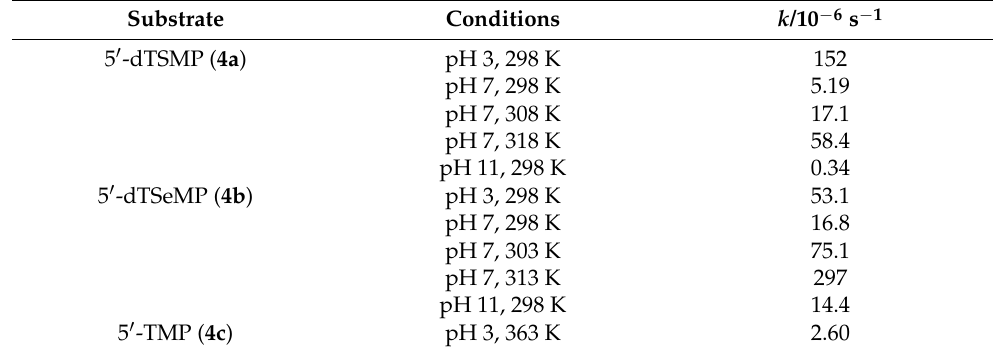
Table 1. Rate constant for the hydrolysis of nucleotides under acidic, neutral and alkaline conditions. Substrate